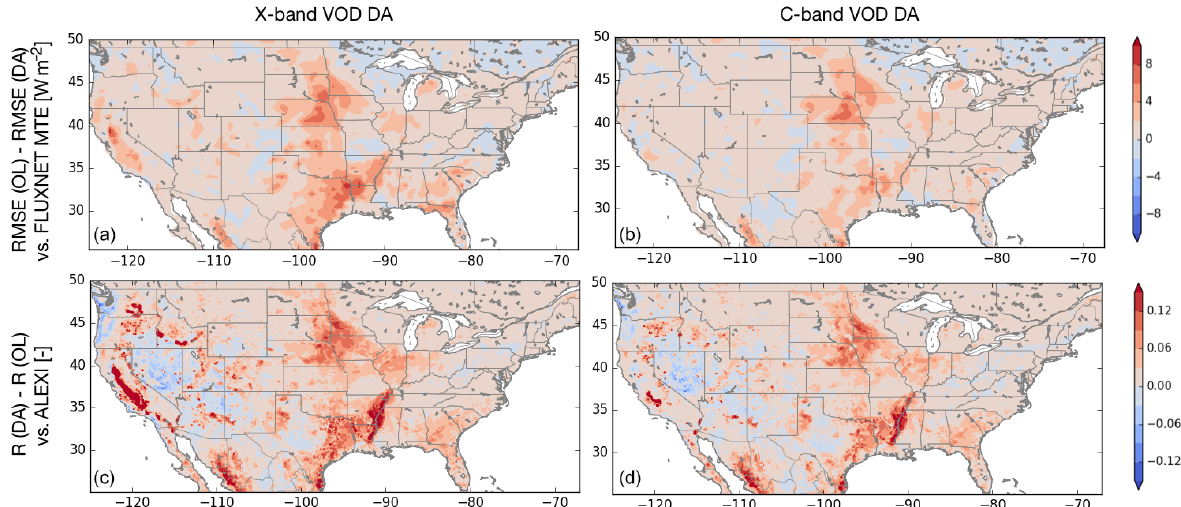
Figure 3. RMSE (Wm − 2 ) or R (–) differences of evapotranspiration from X-band VOD (a, c) and C-band VOD (b, d) assimilation relative to the OL integration, using two reference datasets (FLUXNET MTE used in the top row and ALEXI in the bottom row). The time periods in the comparisons are 2000–2008 and 2000–2018, for FLUXNET MTE and ALEXI, respectively. In each plot, the warm and cool colors represent the improvement and degradation due to VOD DA, respectively.